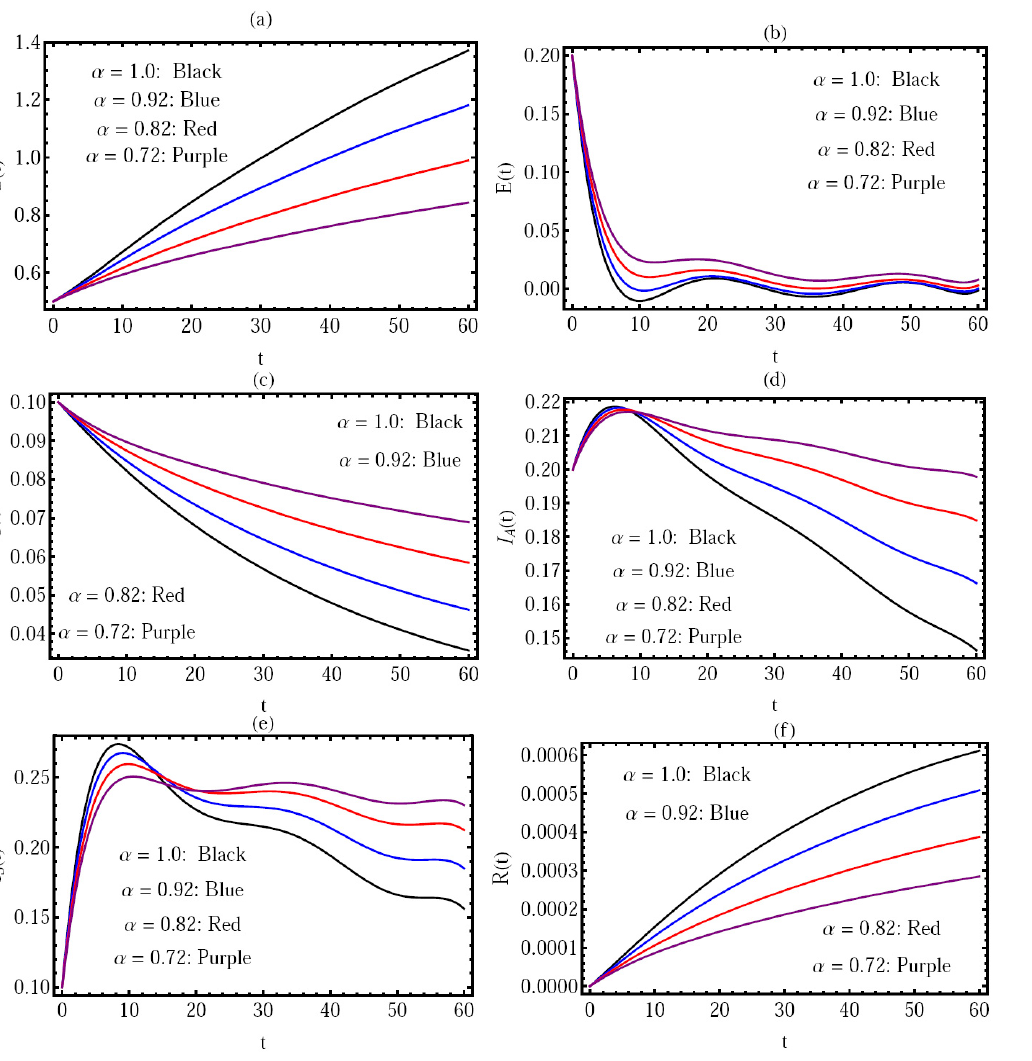
Figure 3. The solution by GRK4M via different values of α ( a – f